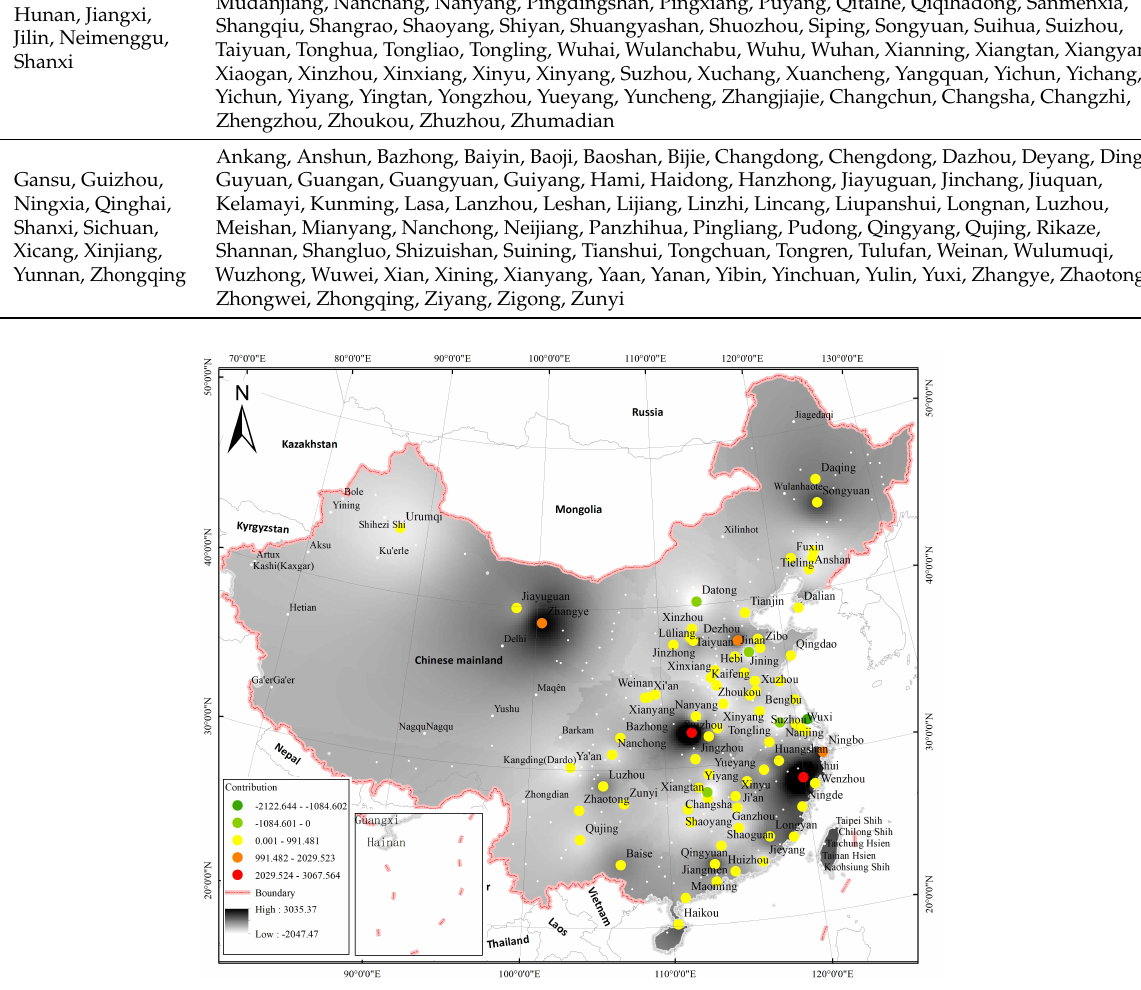
Figure A1. Contribution from the indicator PPC (city population) to land-use intensity revealed in the city-based assessment. Note: in Figures A1–A11, the value for individual cities is the re- gression coefficient and the value of each grid was determined by the regression coefficient of the corresponding indicator using inverse distance weighted (IDW) interpolation